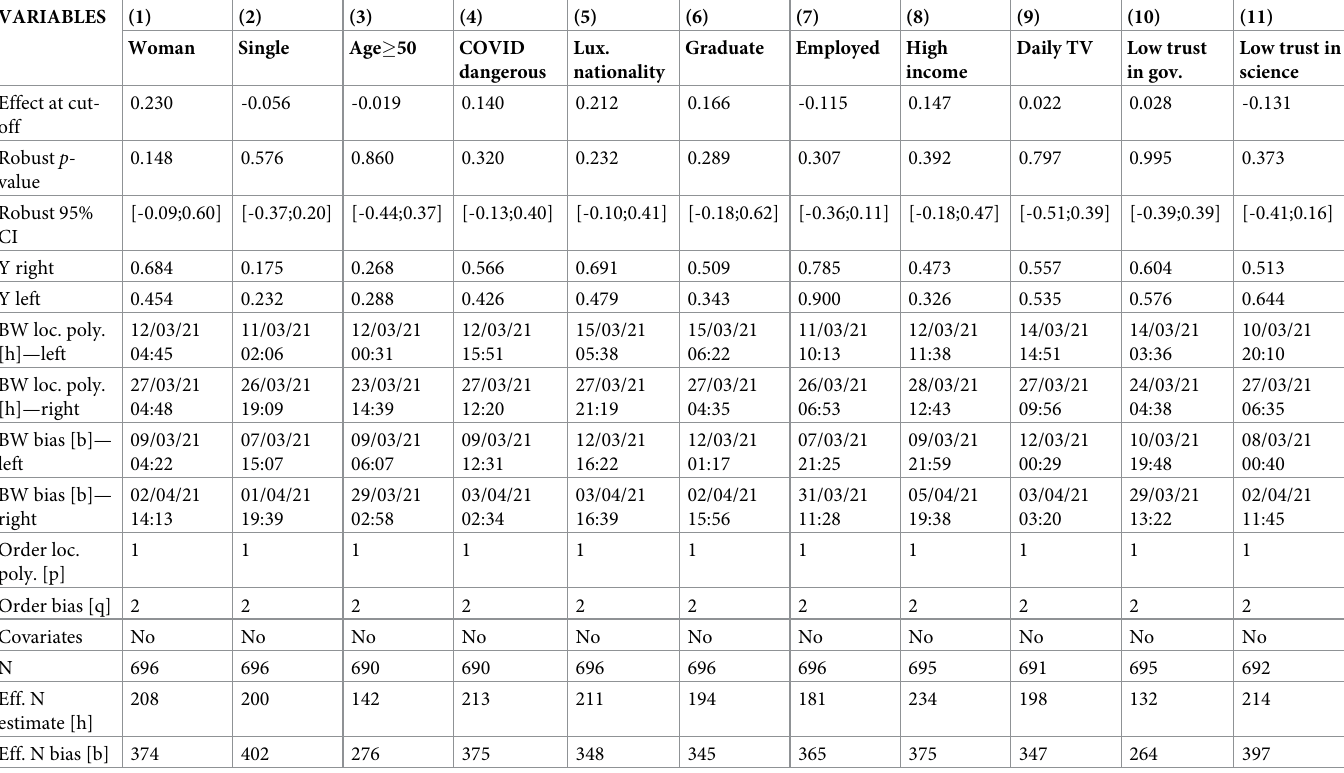
Table 4. Effect on